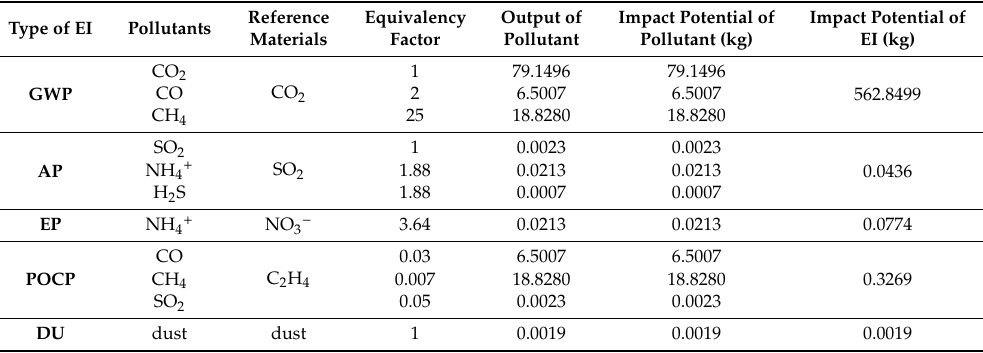
Table 4. Impact potential of liquefied natural gas production in the Shanxi Province (per